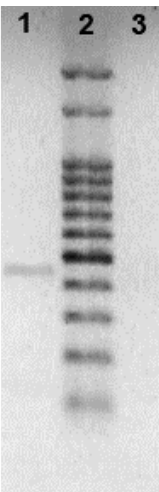
Figure 2. PCR amplification of the sequence-characterized amplified region (SCAR) marker (455 bp) specific for B. bassiana strain GHA (lane 1) which is absent in the Bb-C001 isolate (lane 3). Lane 2, molecular weight marker.